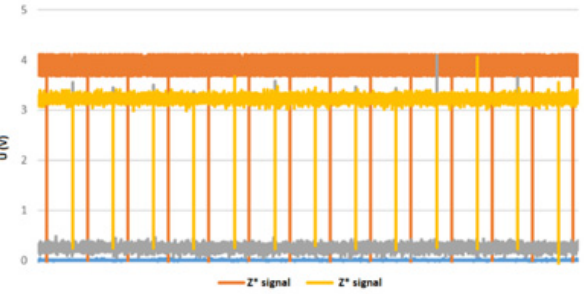
Figure 16. Z and Z* signals for incremental encoders 1 and 2.